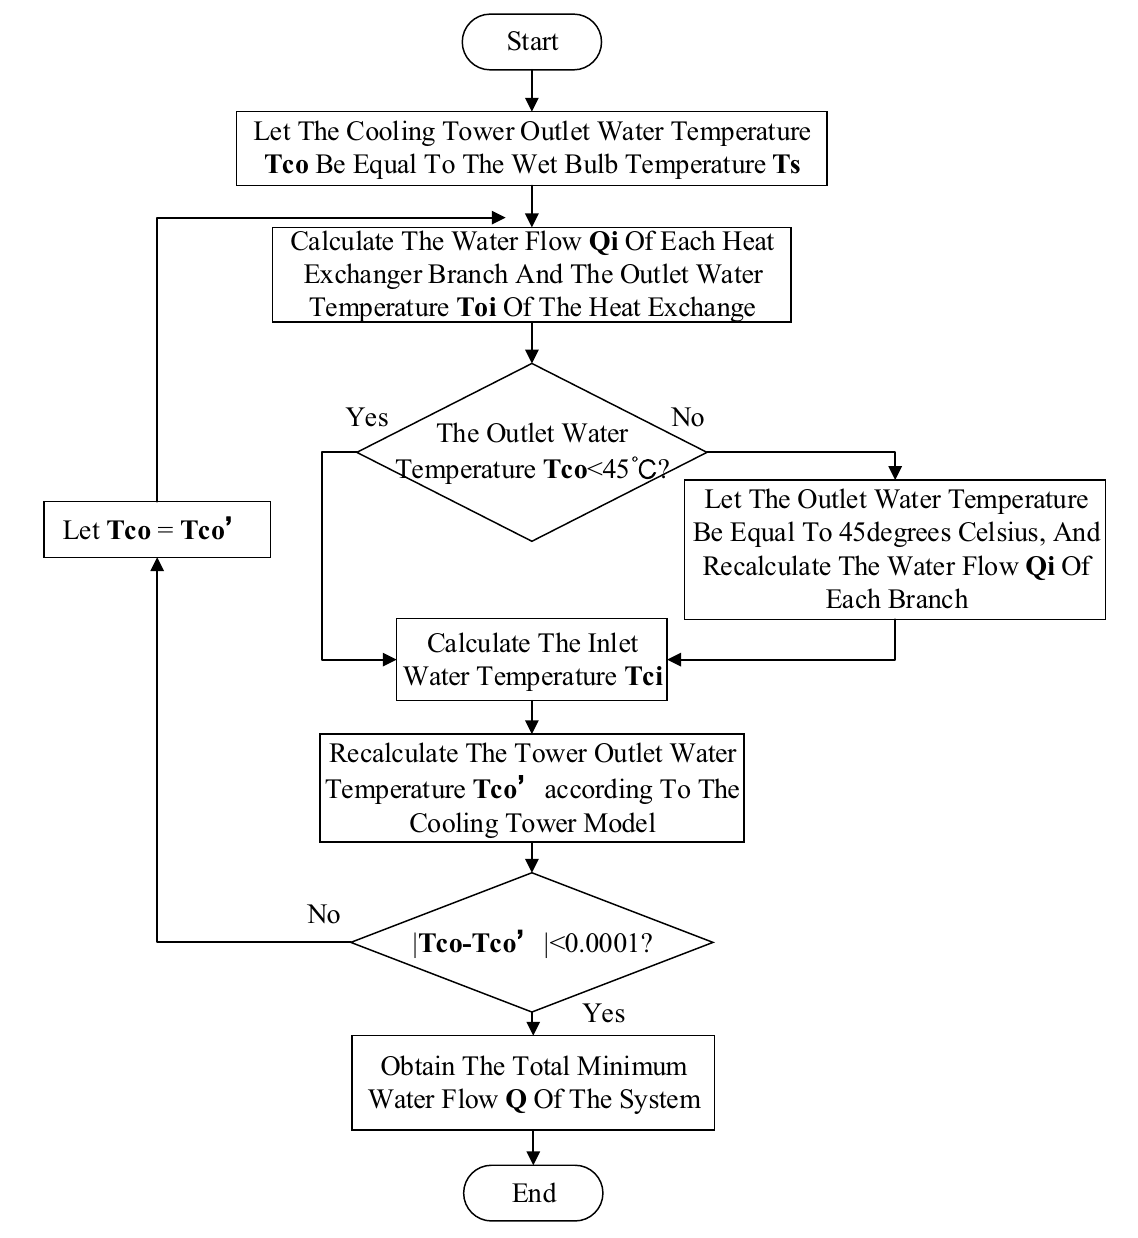
Fig. 1 Flow chart of solving the minimum requirement of circulating water under different working